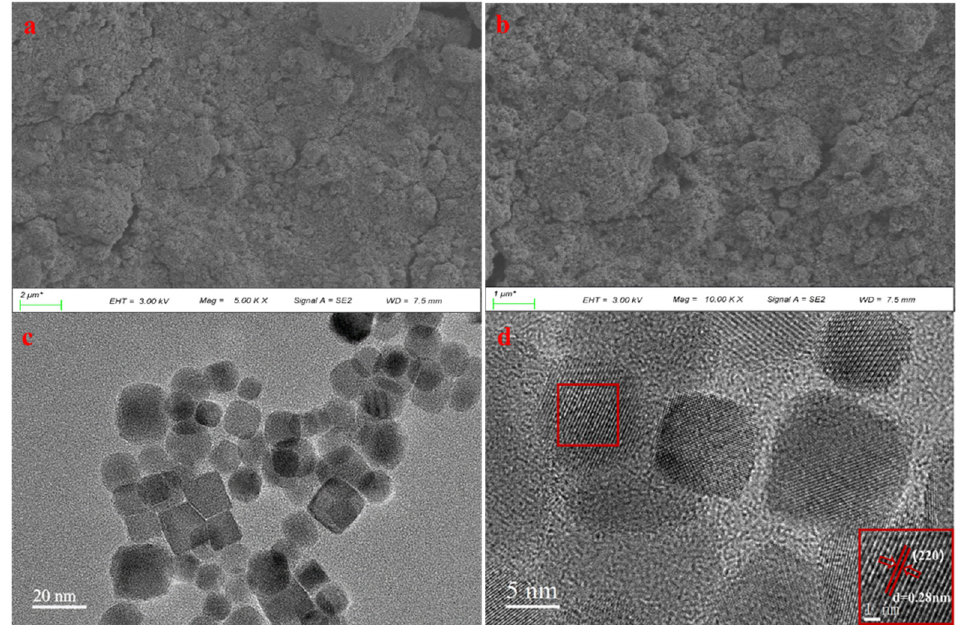
Figure 4. ( a , b ) SEM images of the Co 3 O 4 NPs with different magnifications. ( c , d ) TEM images of the Co 3 O 4 NPs showing the interplanar spacing (220 plane).